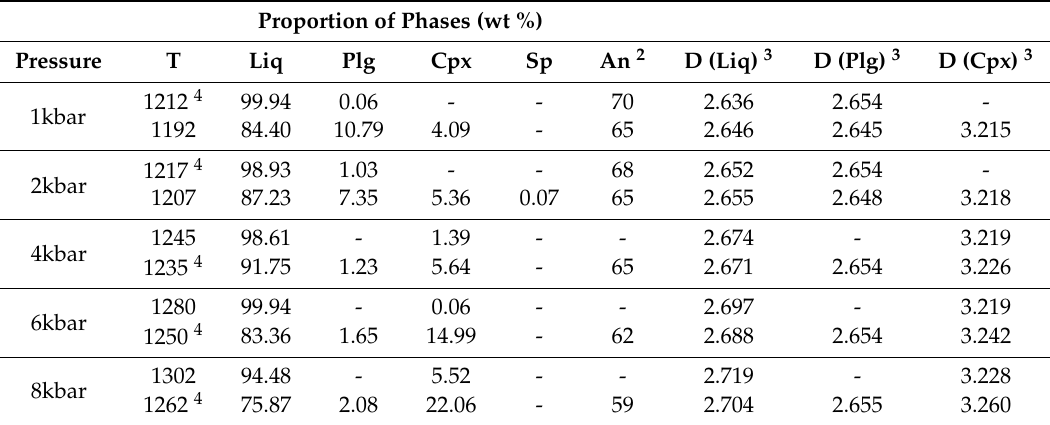
Table 3. Liquid and mineral phase densities calculated with the MELTS 1